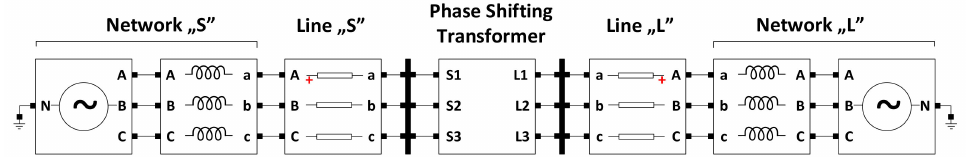
Figure 16. System under test diagram with developed PST model.